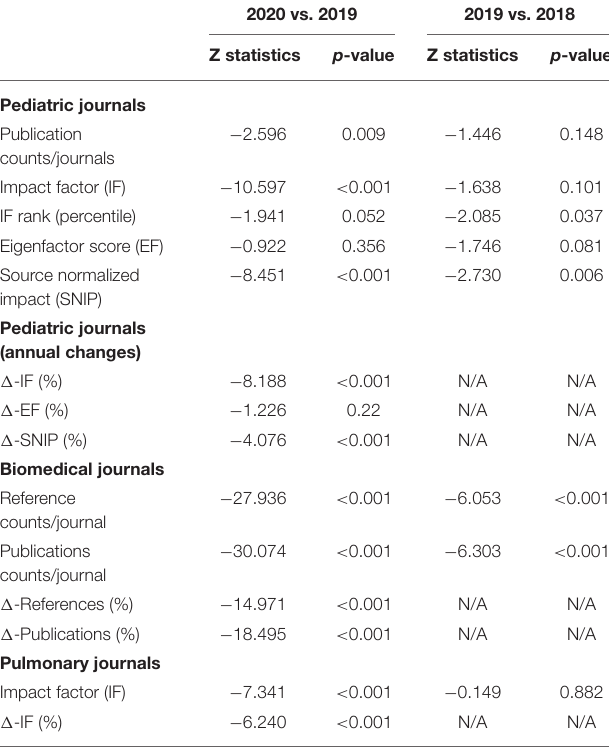
TABLE 2 | The comparative analyses between two consecutive years’ bibliometrics (2020 vs. 2019 and 2019 vs. 2018) using Wilcoxon signed-rank